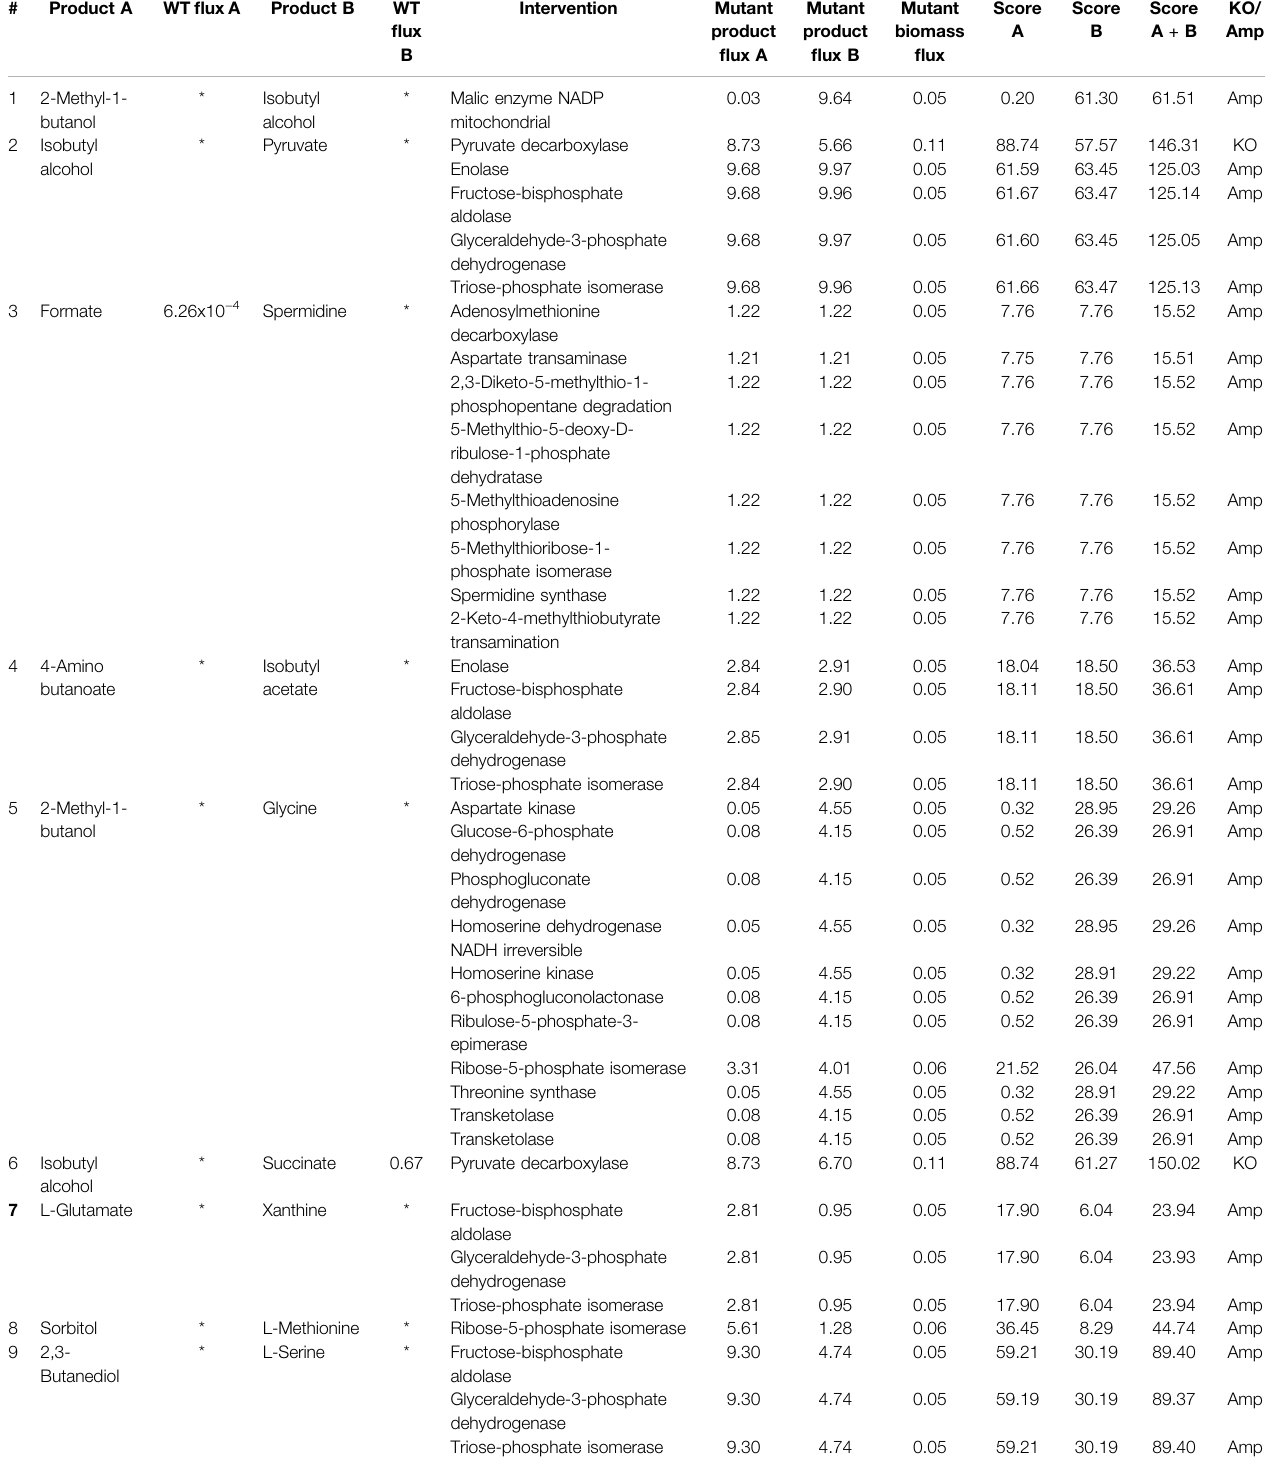
TABLE 4 | Intervention strategies for co-production of pairs of metabolites in S. cerevisiae under anaerobic conditions. # Product